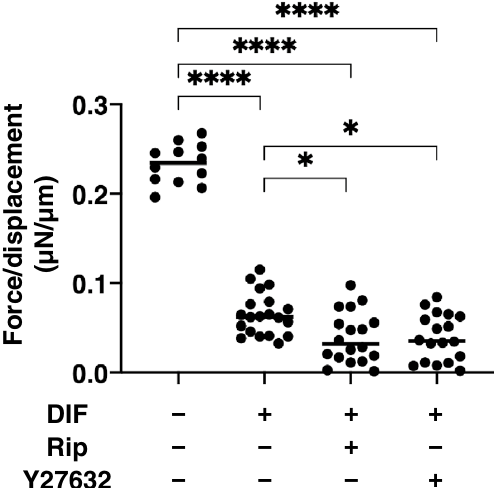
Figure 7. Effects of ROCK-i on physical stiffness of the 3T3-L1 3D organoids. At Day 7, the 3T3-L1 3D organoids of preadipocytes (DIF−) and their adipogenic differentiation (DIF+) without or with 10 µM Ripasudil (Rip) or Y27632 were subjected to a physical solidity analysis by a micro-squeezer. The force required to induce deformation until half diameter was reached (μN/μm force/displacement) were measured and potted.